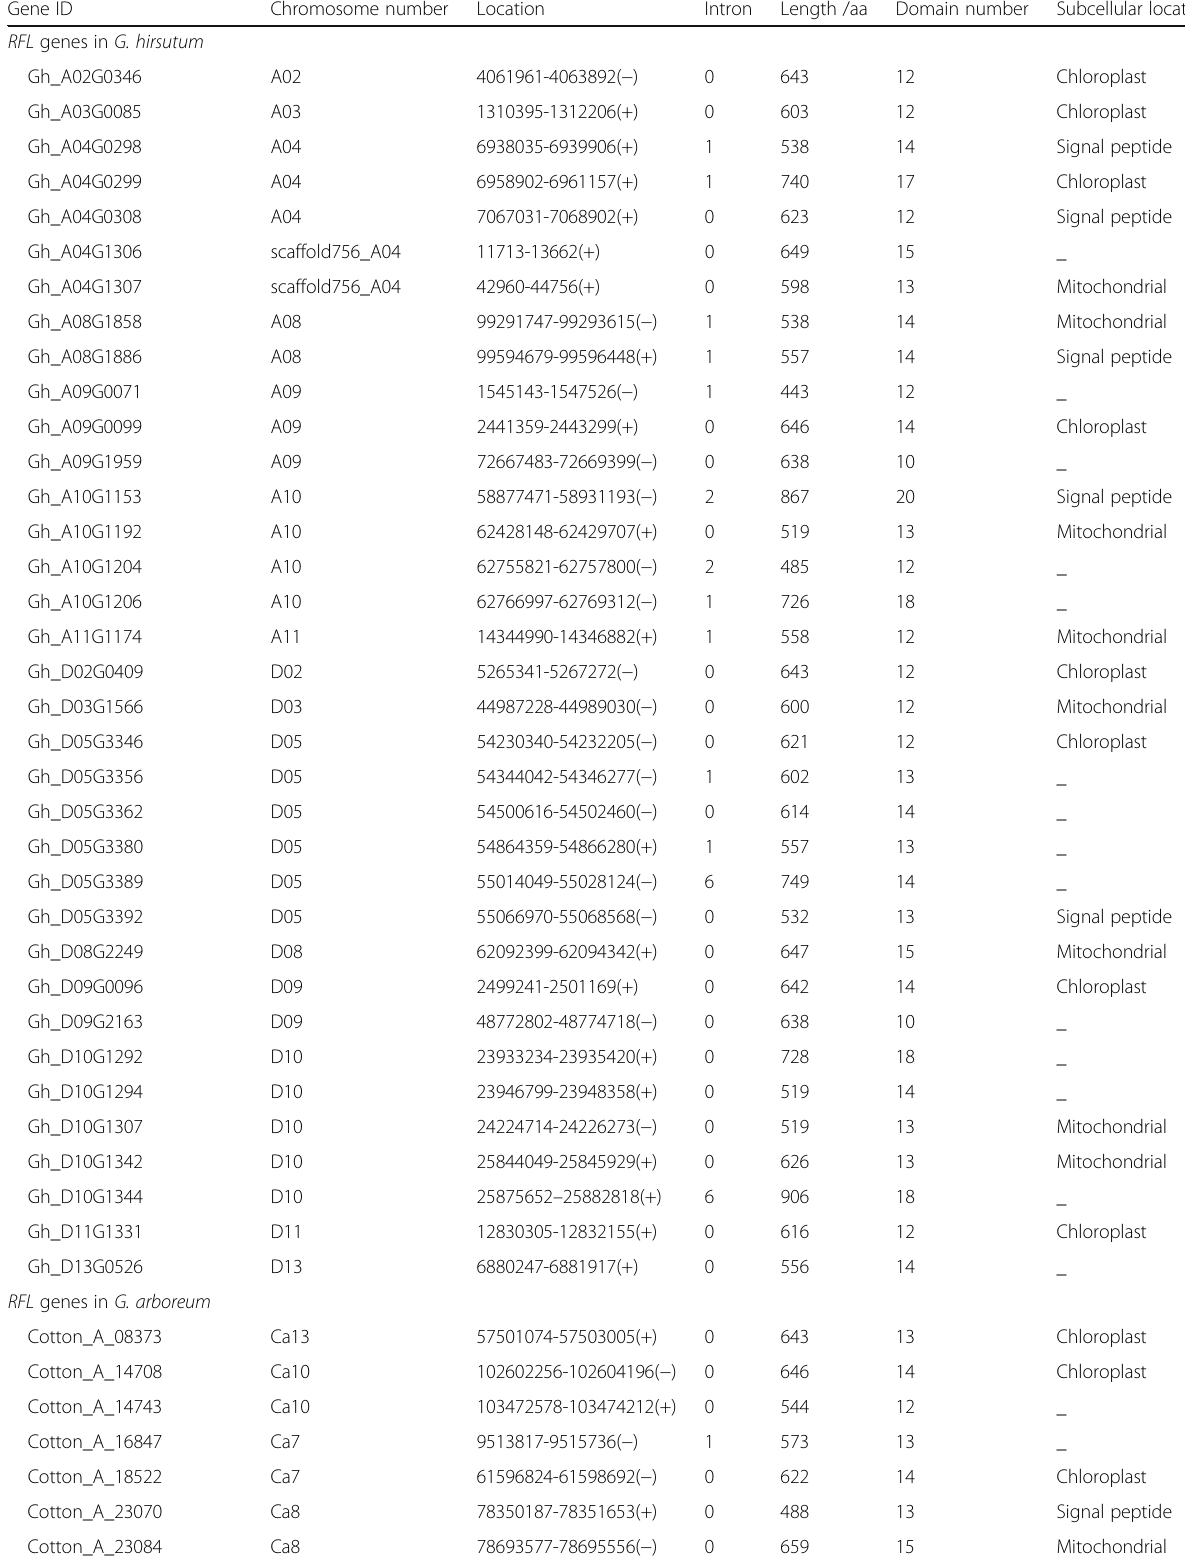
Table 1 Characteristics of RFL genes and predicted properties of RFL proteins in three Gossypium